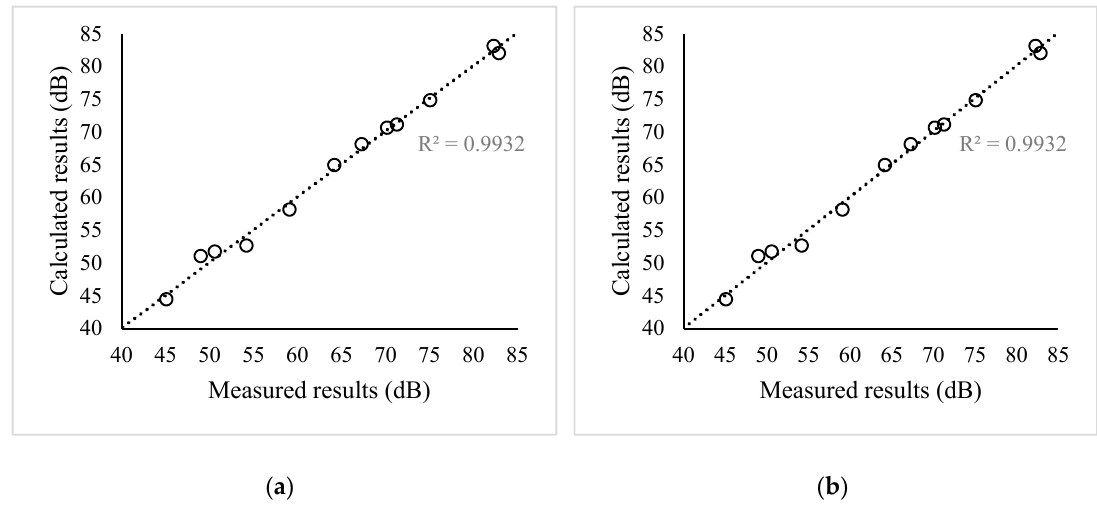
Table 1. Comparison of measured and calculated results (in dB). Point